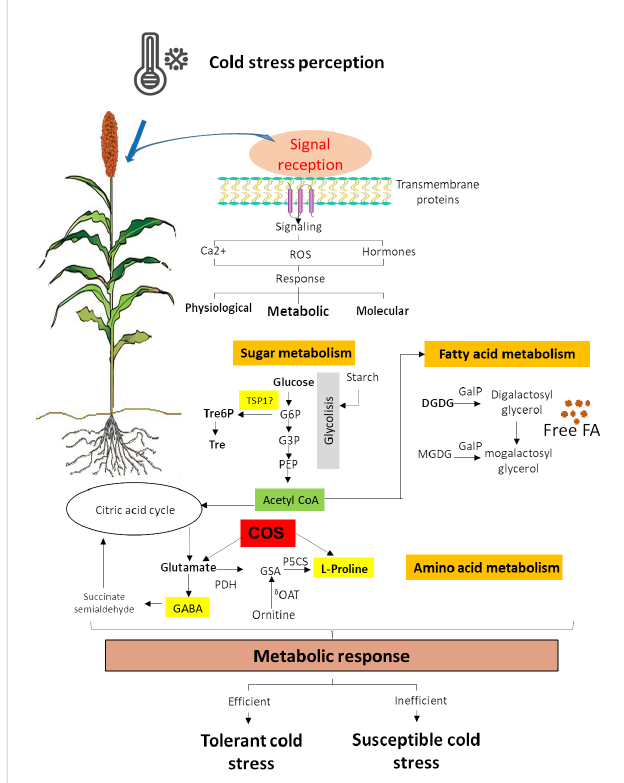
FIGURE 2 Sugar, amino acid, and fatty acid metabolism response to cold